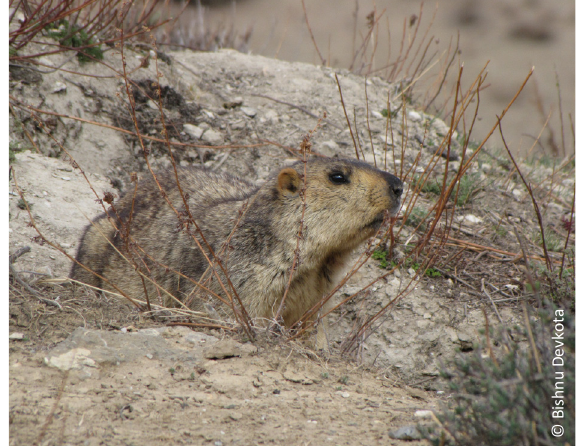
Image 3. Himalayan Marmot Marmota himalayana